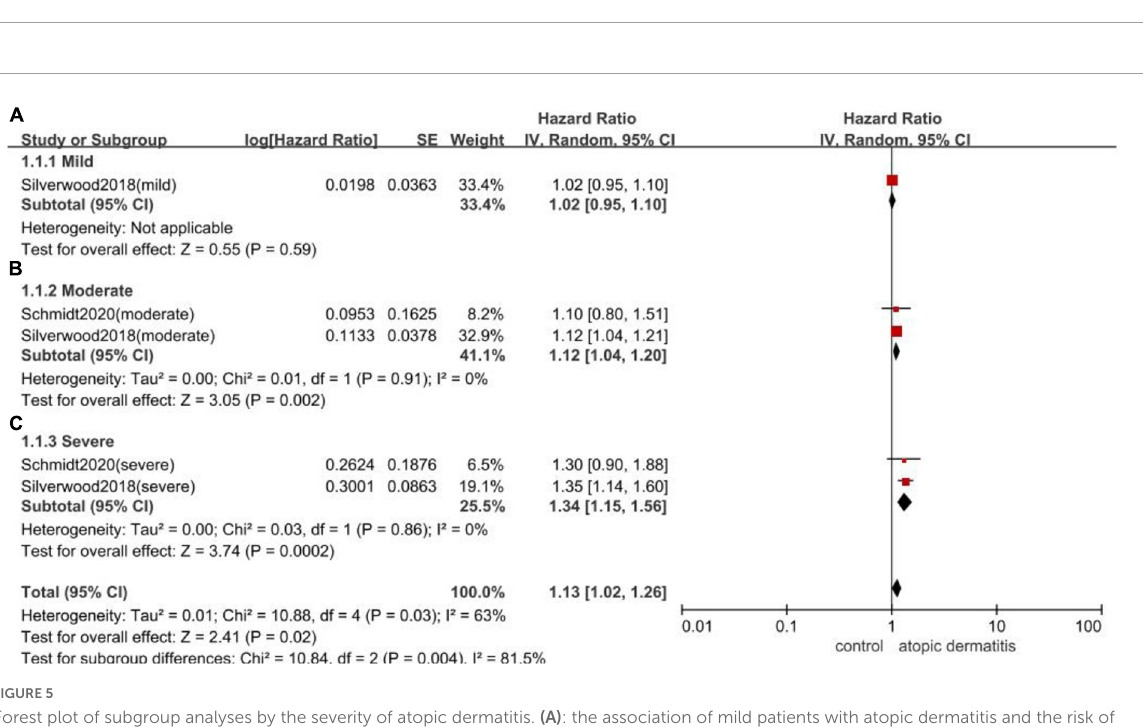
FIGURE4 Forest plot of subgroup analyses by the types of atopic diseases. (A) : the association of asthma and the risk of subsequent AF (HR 1.41, 95% CI 1.25–1.58, I 2 = 75%); (B) : the association of atopic dermatitis and the risk of subsequent AF (HR 1.06, 95% CI 1.01–1.12, I 2 = 0%); (C) : the association of allergic rhinitis and the risk of subsequent AF (HR 1.12, 95% CI 1.10–1.14).